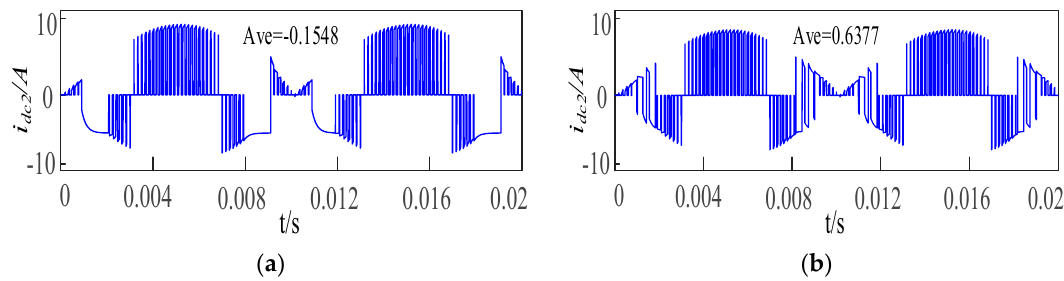
Figure 8. DC current waveform of a low-voltage unit. ( a ) HF-PWM modulation. ( b ) MHF-PWM modulation.